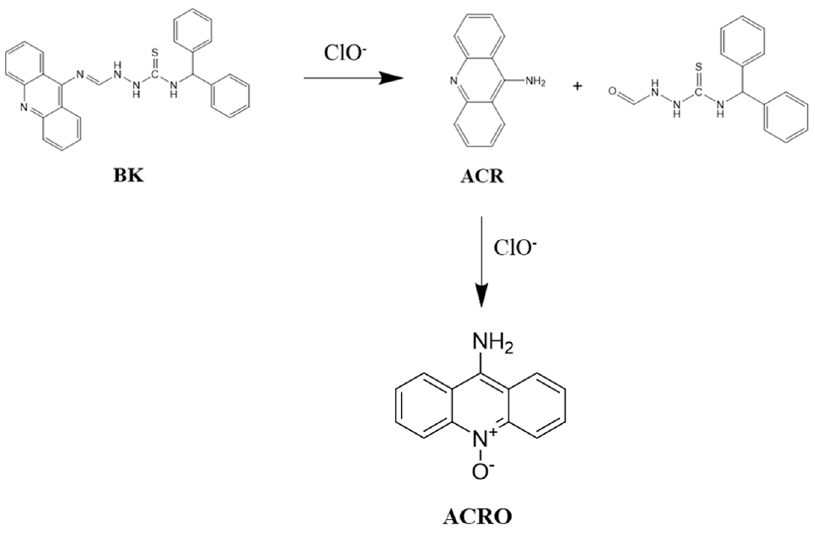
Scheme 2. Cleavage sensing mechanism of BK by ClO − .